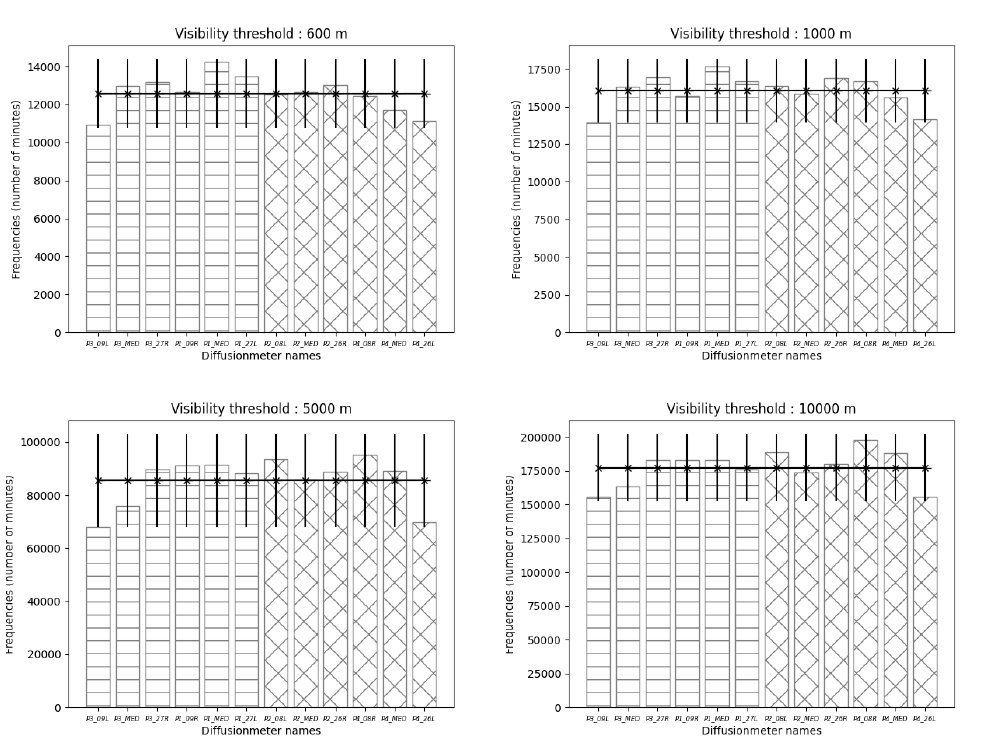
Figure 5. Frequency of occurrence (minutes) of visibility lower than different thresholds (600 m, 1000 m, 5000 m and 10,000 m) for the 12 sensors used (see Figure 1 and Table 1 for the name and location of visibility sensors). The horizontal and vertical bars correspond, respectively, to the mean value and the standard deviation . Note that the vertical axes are different in the different